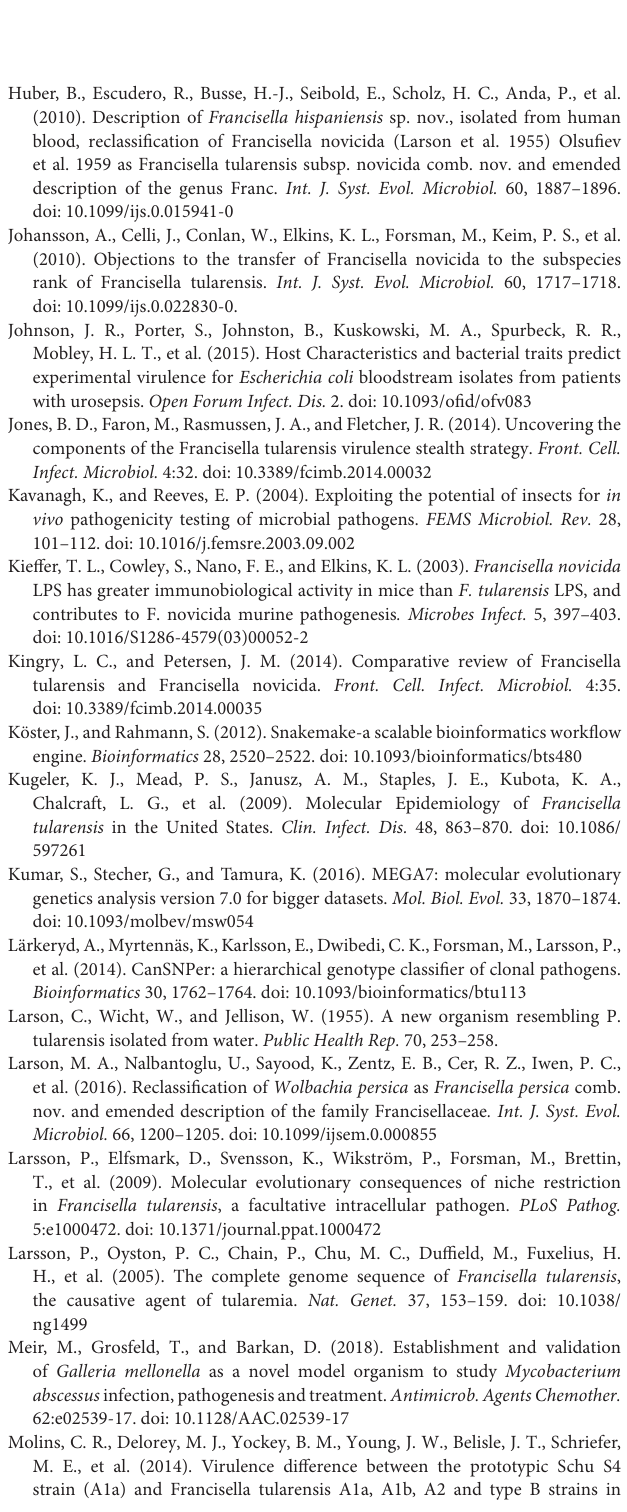
Supplementary Table 1 | P -values obtained from the log rank test for comparison of strains concerning survival estimates at (A) 37 ◦ C and Tukey-Kramer